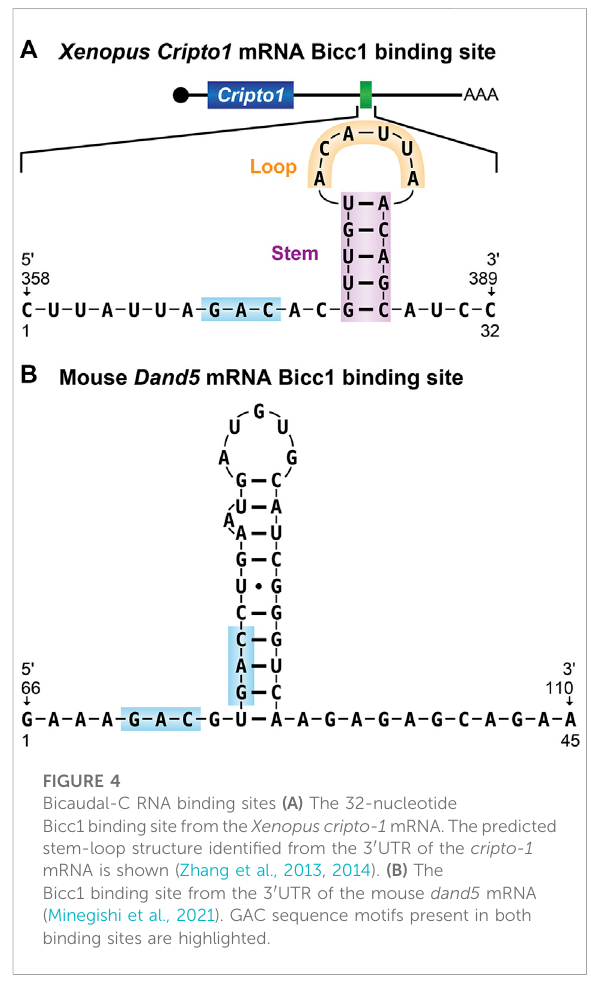
FIGURE 4 Bicaudal-C RNA binding sites (A) The 32-nucleotide Bicc1bindingsitefromthe Xenopuscripto-1 mRNA.Thepredicted stem-loop structure identi fi ed from the 3 ′ UTR of the cripto-1 mRNA is shown (Zhang et al., 2013, 2014). (B) The Bicc1 binding site from the 3 ′ UTR of the mouse dand5 mRNA (Minegishi et al., 2021). GAC sequence motifs present in both binding sites are